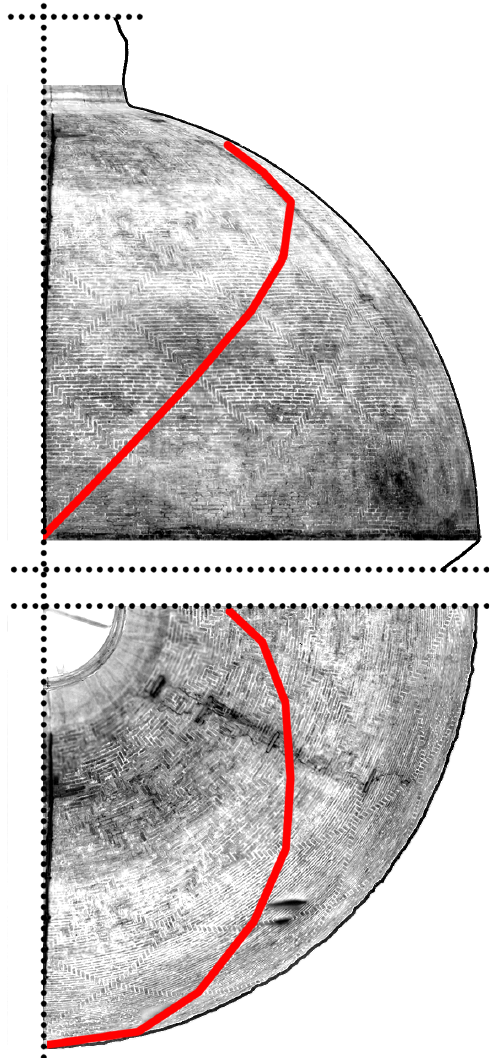
Figure 5: Survey of Simon Mago dome (San Pietro basilica), the loxodromic curve highlighted in red. Orthographic projections, top: half-section view, bottom: one-quarter hyposcopic